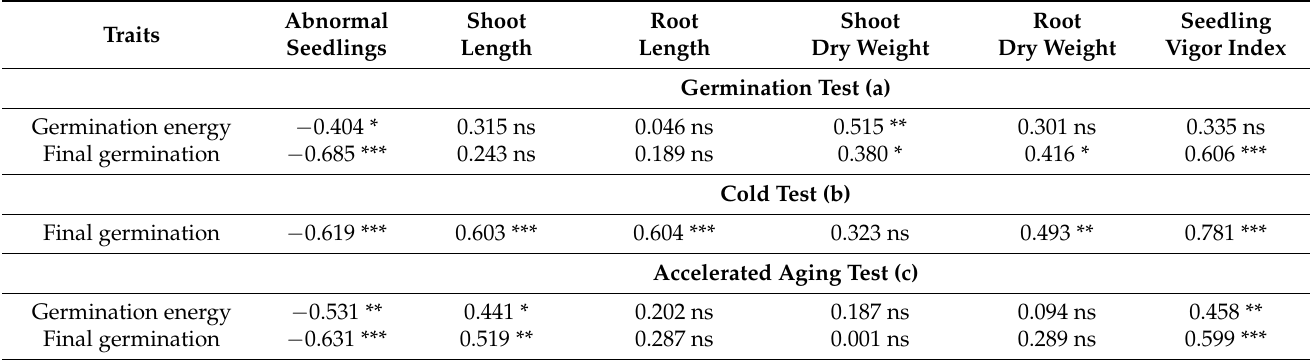
Table 5. Pearson correlations between germination and other parameters of soybean. ( a ) Germination Test; ( b ) Cold Test; ( c ) Accelerated Aging